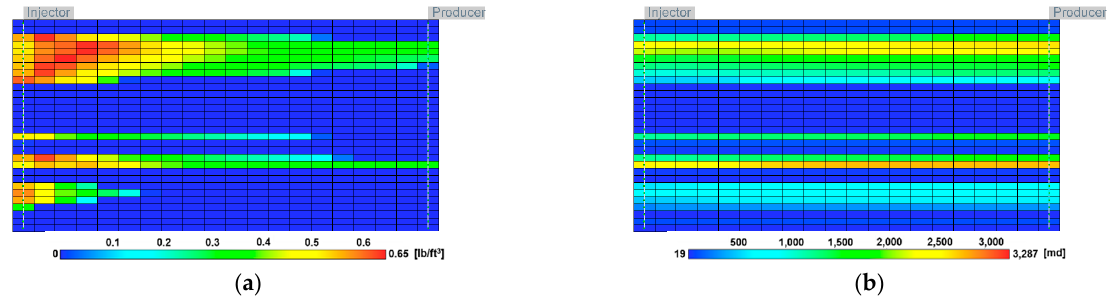
Figure 6. Improvements of recovery efficiency by MEOR in field applications: ( a ) recovery factor, ( b ) water-oil ratio.